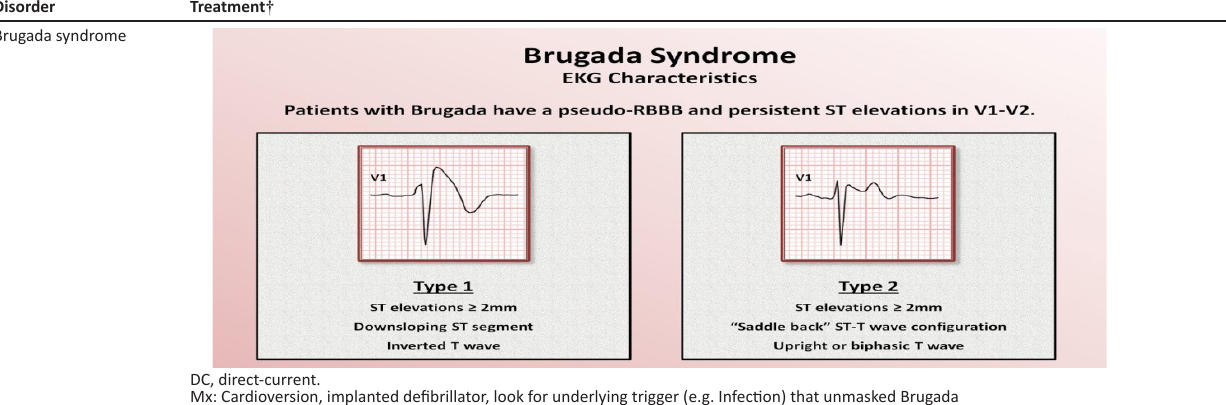
TABLE 2 (Continues…): Some treatments for arrhythmias. Disorder Treatment † Brugada